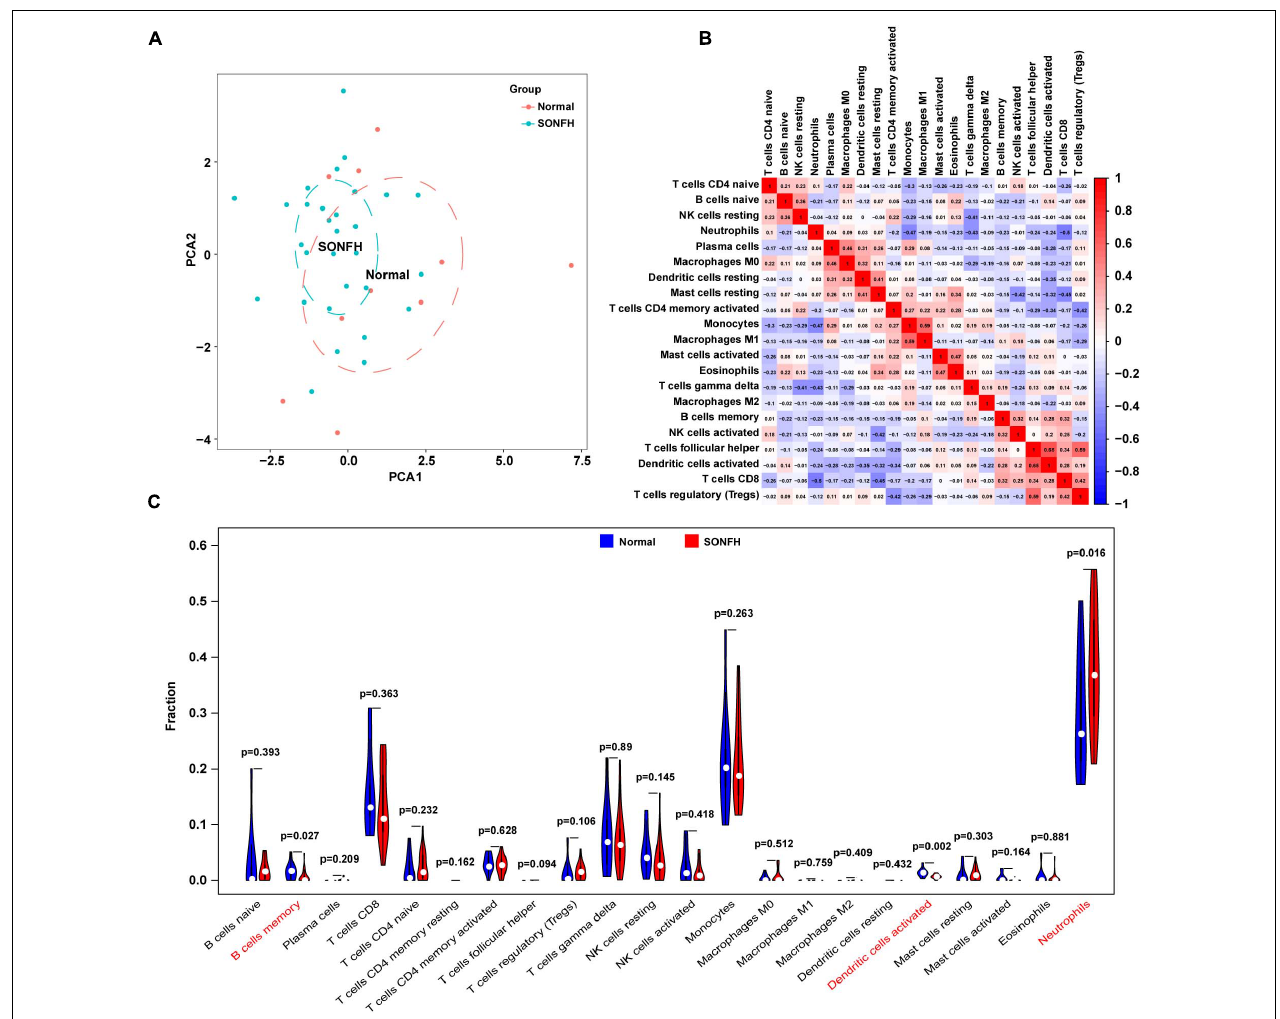
FIGURE 7 | Evaluation and visualization of immune cell infiltration. (A) PCA cluster plot of immune cell infiltration between SONFH samples and control samples. (B) Correlation heat map of 22 types of immune cells and one kind of immune cell with no difference were removed. The size of the colored squares represents the strength of the correlation; red represents a positive correlation and blue represents a negative correlation. (C) Violin diagram of the proportion of 22 types of immune cells. The red marks represent the difference in infiltration between the two groups of